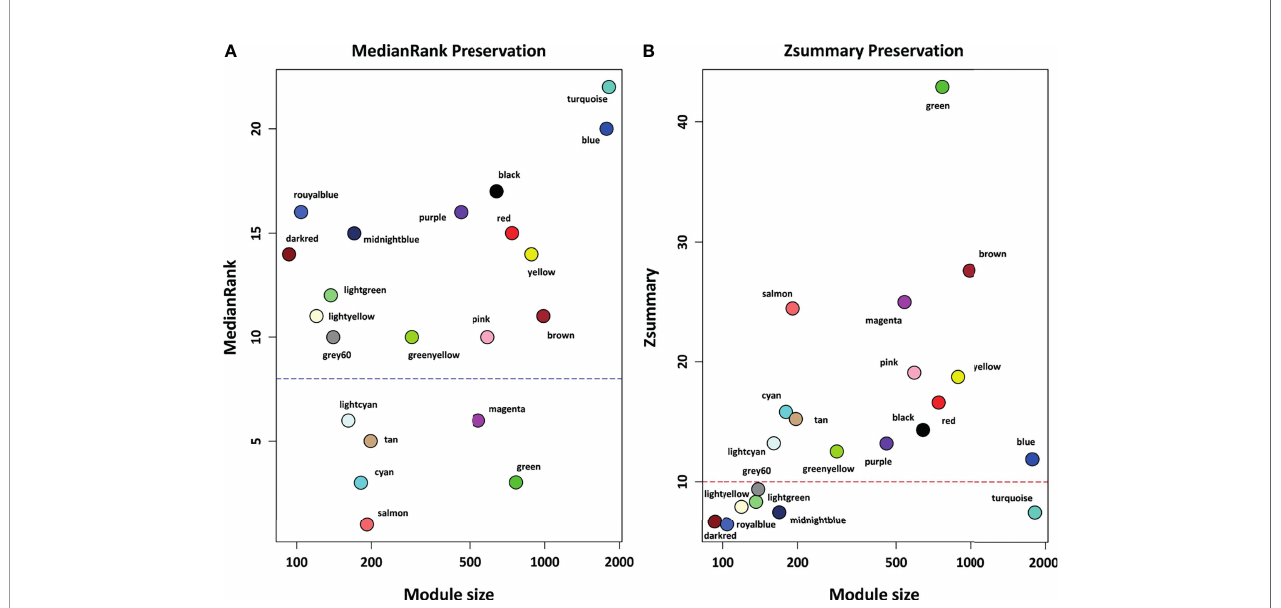
FIGURE 3 | The preservation status of the respective modules. (A) MedianRank preservation results. The y axis represents medianRank values and x axis represent module size. Each point with a speci fi c color represents the corresponding module. (B) Zsummary preservation results. The y axis represents Zsummary values and x axis represents the module size. Each point with a speci fi c color represents the corresponding module. Modules with medianRank ≥ 8 (the blue dashed line) or Zsummary ≤ 10 (the red dashed line) were considered non-preserved between healthy controls and COVID-19 samples.